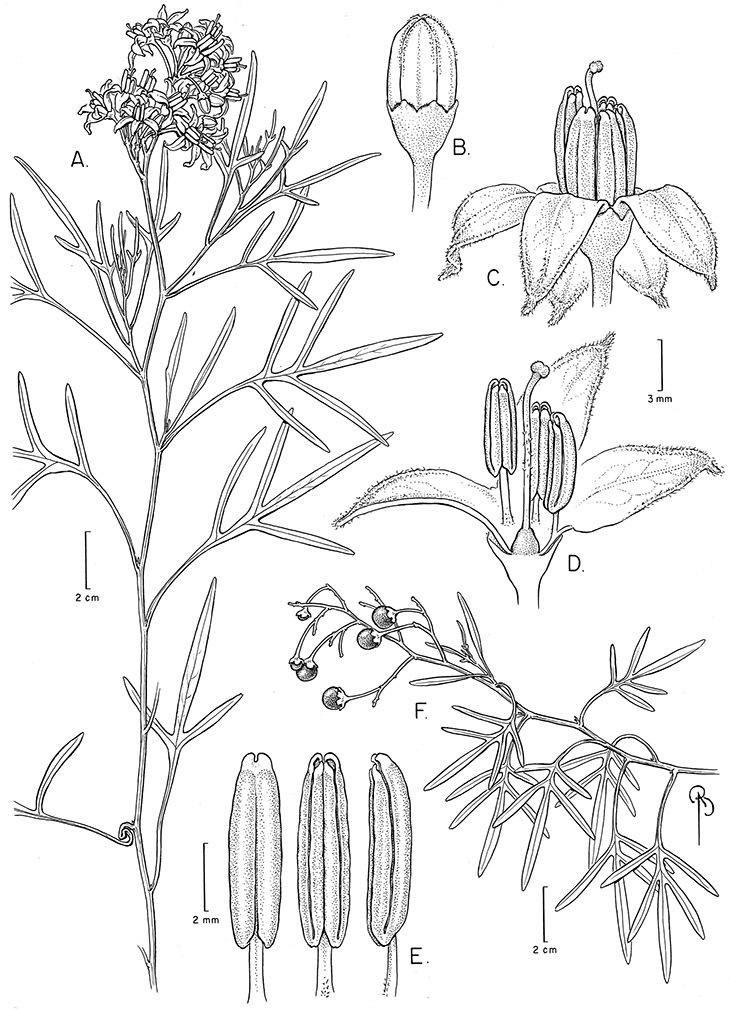
Solanum angustifidum Bitter. (A drawn from Tressens et al. 560
B–E drawn from Pedersen 7150
F drawn from Cristóbal et al. 1618). Illustration by Bobbi Angell.